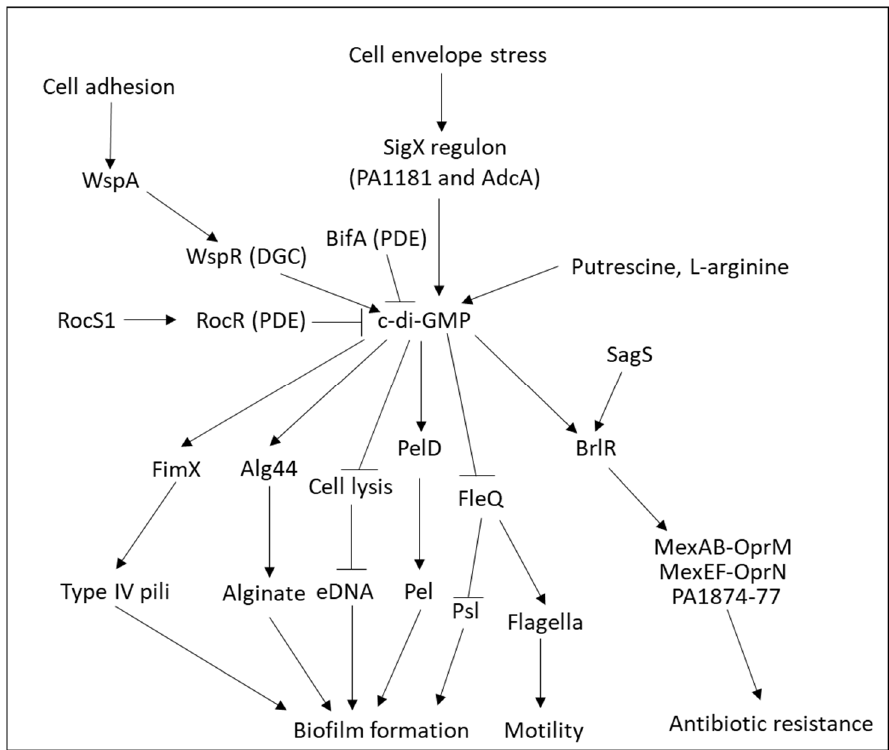
Figure 11. The role of c-di-GMP in biofilm formation and antibiotic resistance. The secondary metabolite c-di-GMP is a central mediator of biofilm formation in Gram-negative bacteria. It modulates the expression of various genes (e.g., fimX , alg44 , pelD , fleQ ) involved in the production of pili, flagella, alginate, and exopolysaccharides (Pel and Psl) that contribute to the development of the biofilm. Moreover, it induces the transcriptional responser BrlR that regulates the expression of efflux pumps involved in antibiotic resistance. The activity of BrlR is affected by SagS, which is involved in the molecular switch from a planktonic to a biofilm lifestyle (see Figure 12 below). The c-di-GMP level is affected by various factors including cell adhesion and cell envelope stress. Its synthesis is mediated by diguanylate cyclases (DGCs) and degraded by c-di-GMP phosphodiesterases (PDEs). The c-di-GMP level is controlled by enzymes that synthesize c-di-GMP (e.g., diguany- late cyclases (DGCs) carrying a GGDEF active site motif) and enzymes that degrade the molecule (e.g., c-di-GMP phosphodiesterases (PDEs) carrying either EAL or HD-GP domains) [662]. The Pseudomonas aeruginosa genome encodes one of the highest num- bers of DGCs and PDEs: 18 GGDEF, 5 EAL, 16 GGDEF/EAL, and 3 HD-GYP predicted proteins [517]. Upon contact of Pseudomonas aeruginosa with a surface, the membrane- bound receptor, WspA, becomes activated and triggers c-di-GMP production by the DGC WspR [669]. c-di-GMP, in turn, downregulates the flagellum motility machinery, thereby forcing the bacteria into a sessile growth mode